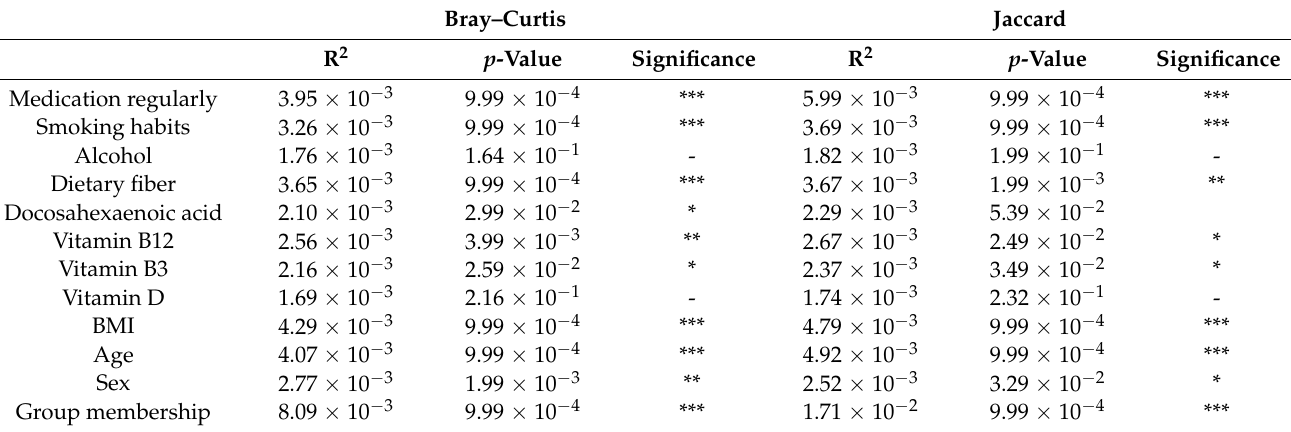
Table 4. Bray–Curtis and Jaccard adjusted beta diversity between the neurological subgroups and healthy controls. Bray–Curtis Significance